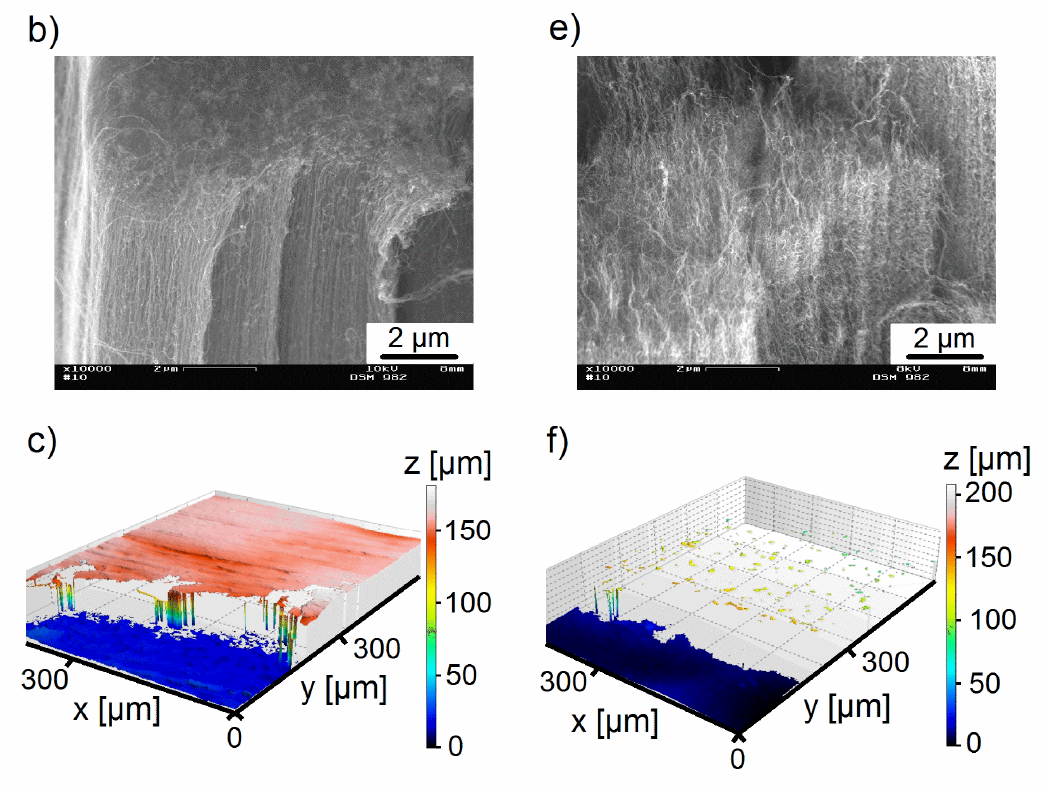
Figure 3. SEM image of VACNT surface with lower and higher magnification ( a , b ) before and ( d , e ) after film transfer and confocal microscopy image of VACNT on nickel foil before ( c ), and on primer-coated aluminum foil ( f ) after film